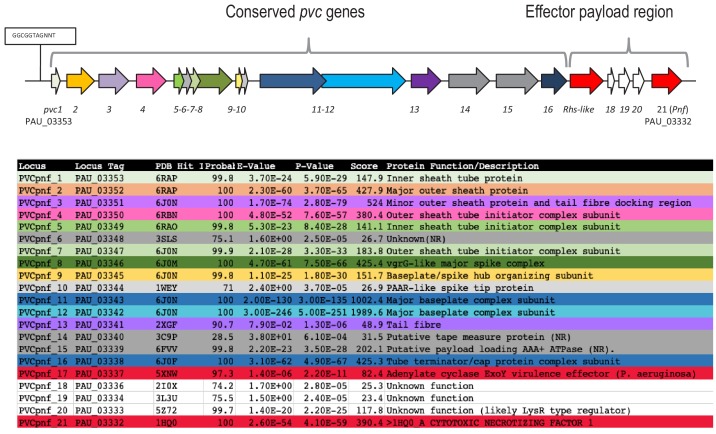
A map of the model class I PaATCC43949 PVCpnf operon showing two effector genes in the payload region in red and a table, both colour matched to the description of subunit-structure relationship described in the recent CryoEM structure paper (Jiang et al., 2019).Payload effectors are in red and ‘NR’ means subunit not resolved in the structure.